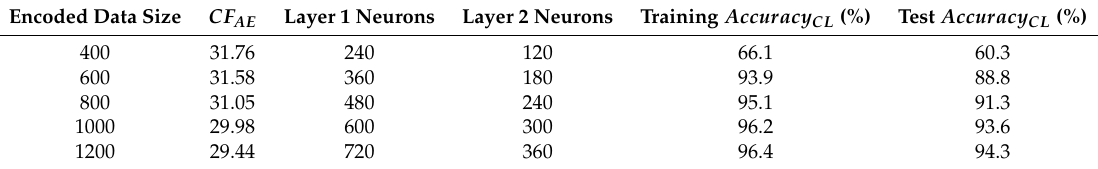
Table 3. Accuracy of the proposed localization ANN with varying encoded data size.